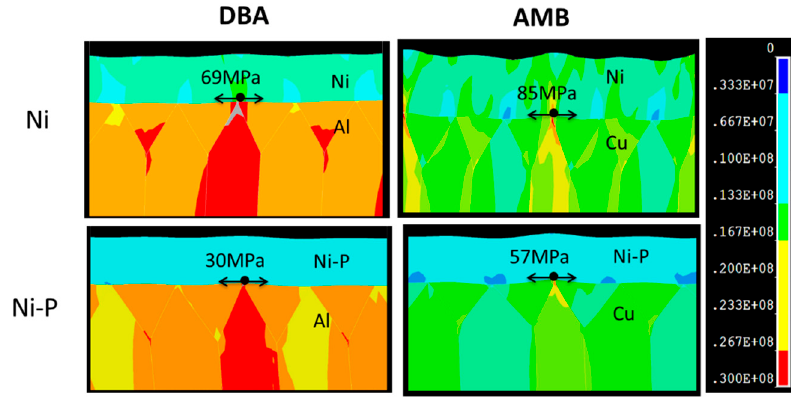
Figure 13. The maximum principal stress distribution for the Ni and Ni–P layers on DBA/AMB substrates with Si 3 N 4 at 250 °C during the thermal shock cycling test.